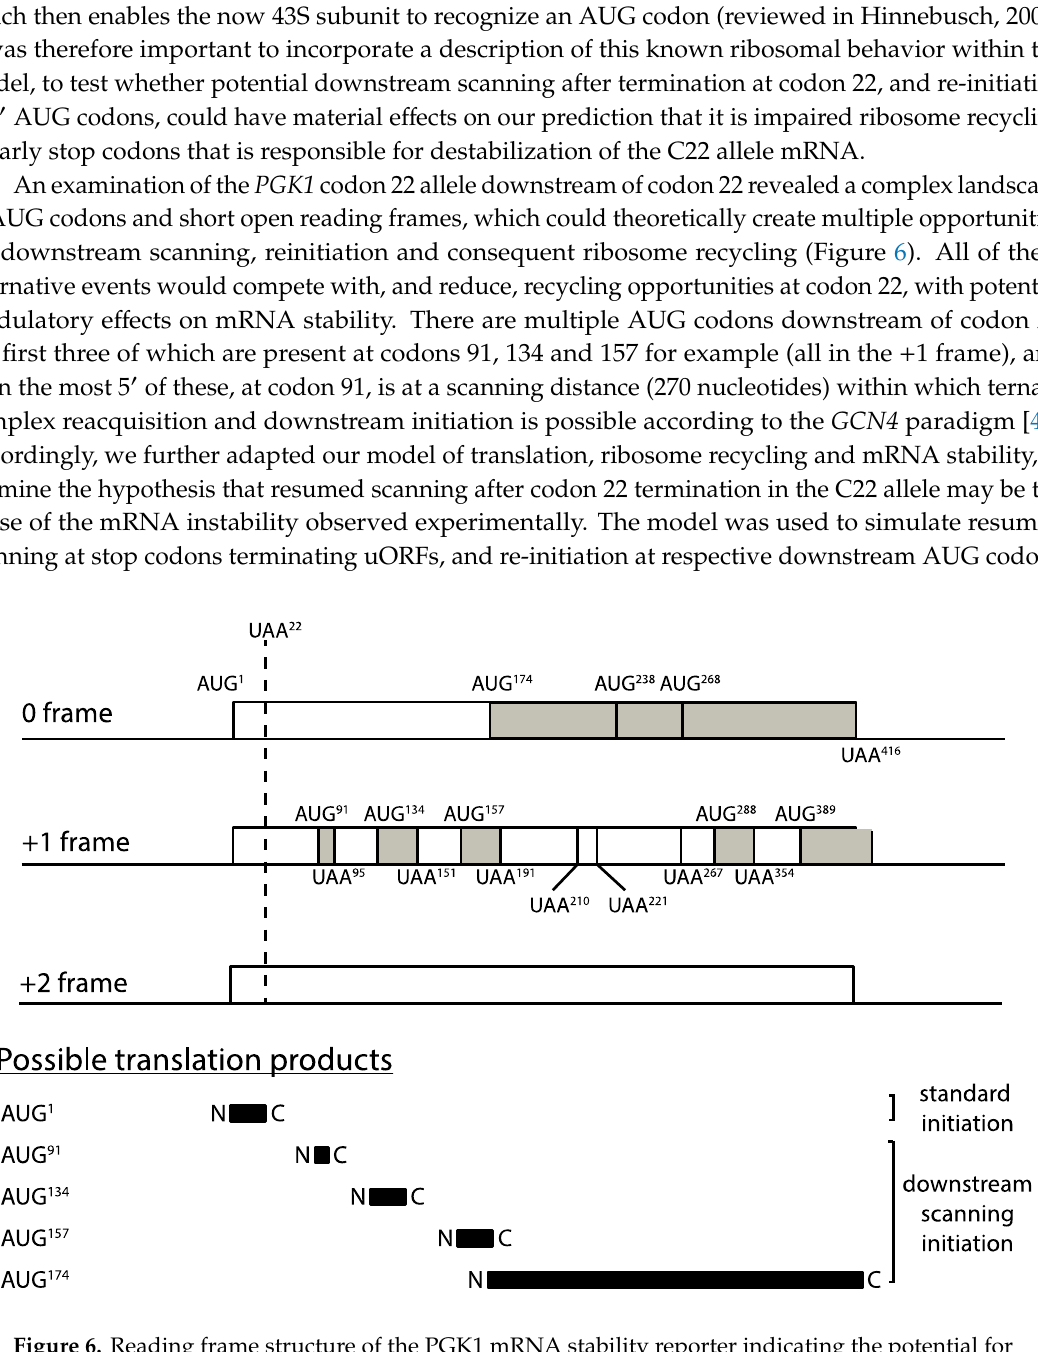
Figure 6. Reading frame structure of the PGK1 mRNA stability reporter indicating the potential for resumed scanning downstream of the codon 22 premature stop codon. The positions of AUG initiation codons downstream of codon 22 are indicated in units of codons, along with the potential open reading frames that they initiate, in each of the three potential translational reading frames.